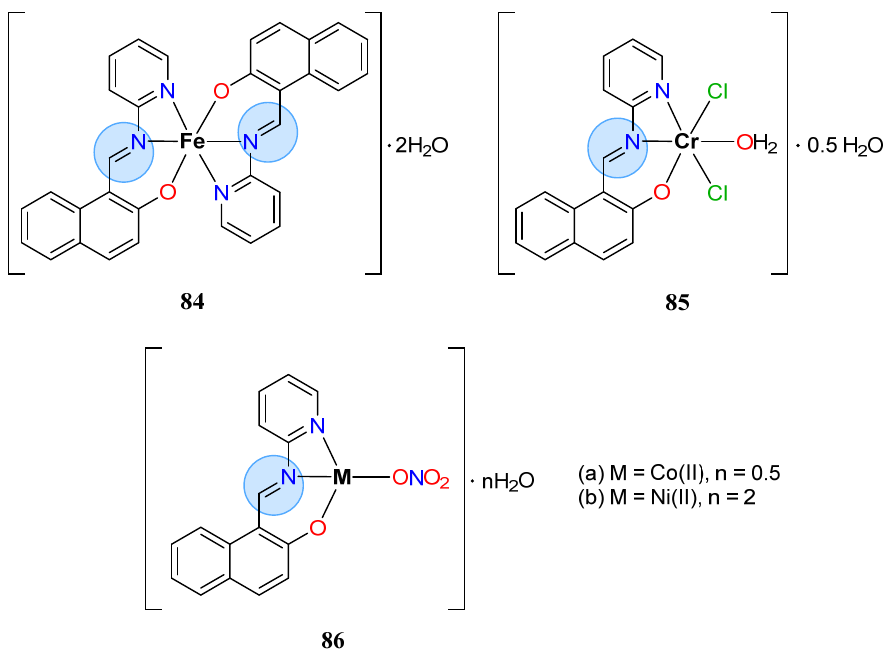
Figure 43. Complexes incorporating the 2-(( E )-(pyridine-2-ylimino)methyl)napthalen-1-ol ligand studied for their antimicrobial activity.